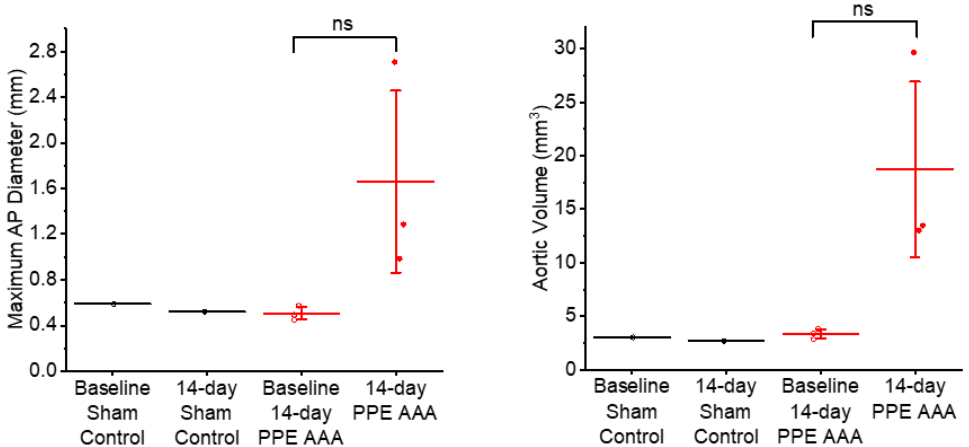
Figure 2. Aortic anterior–posterior diameters and volumes based on three-dimensional USS of 14-day PPE AAA vs. 14-day sham control aortae. ns: not significant on two-sample t test.